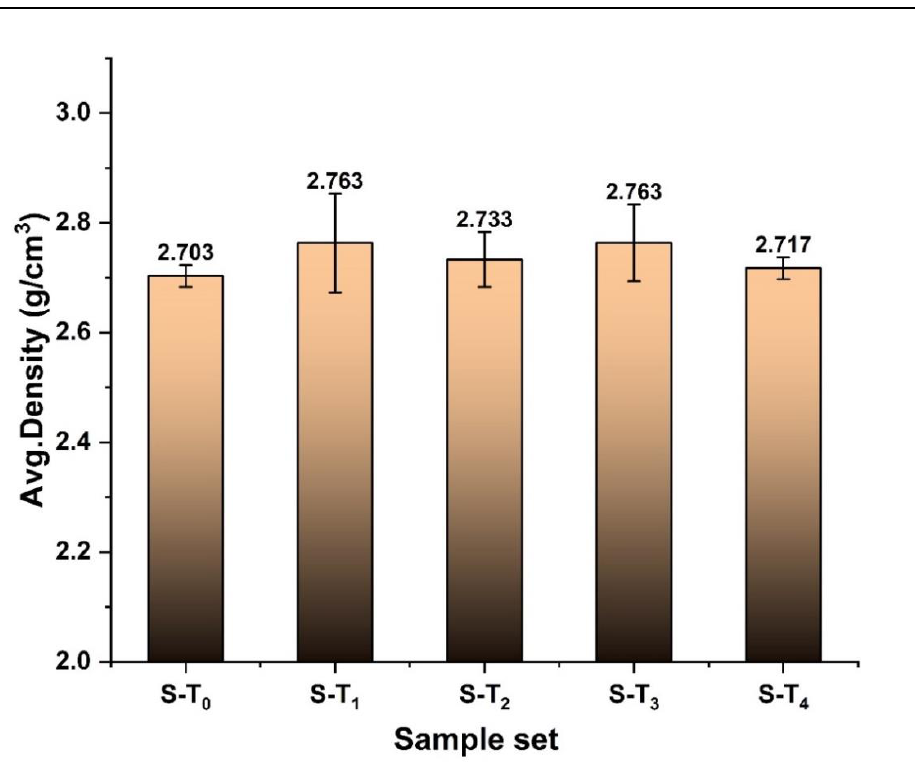
Figure 9. The average density for a different set of specimens tested at different temperatures.